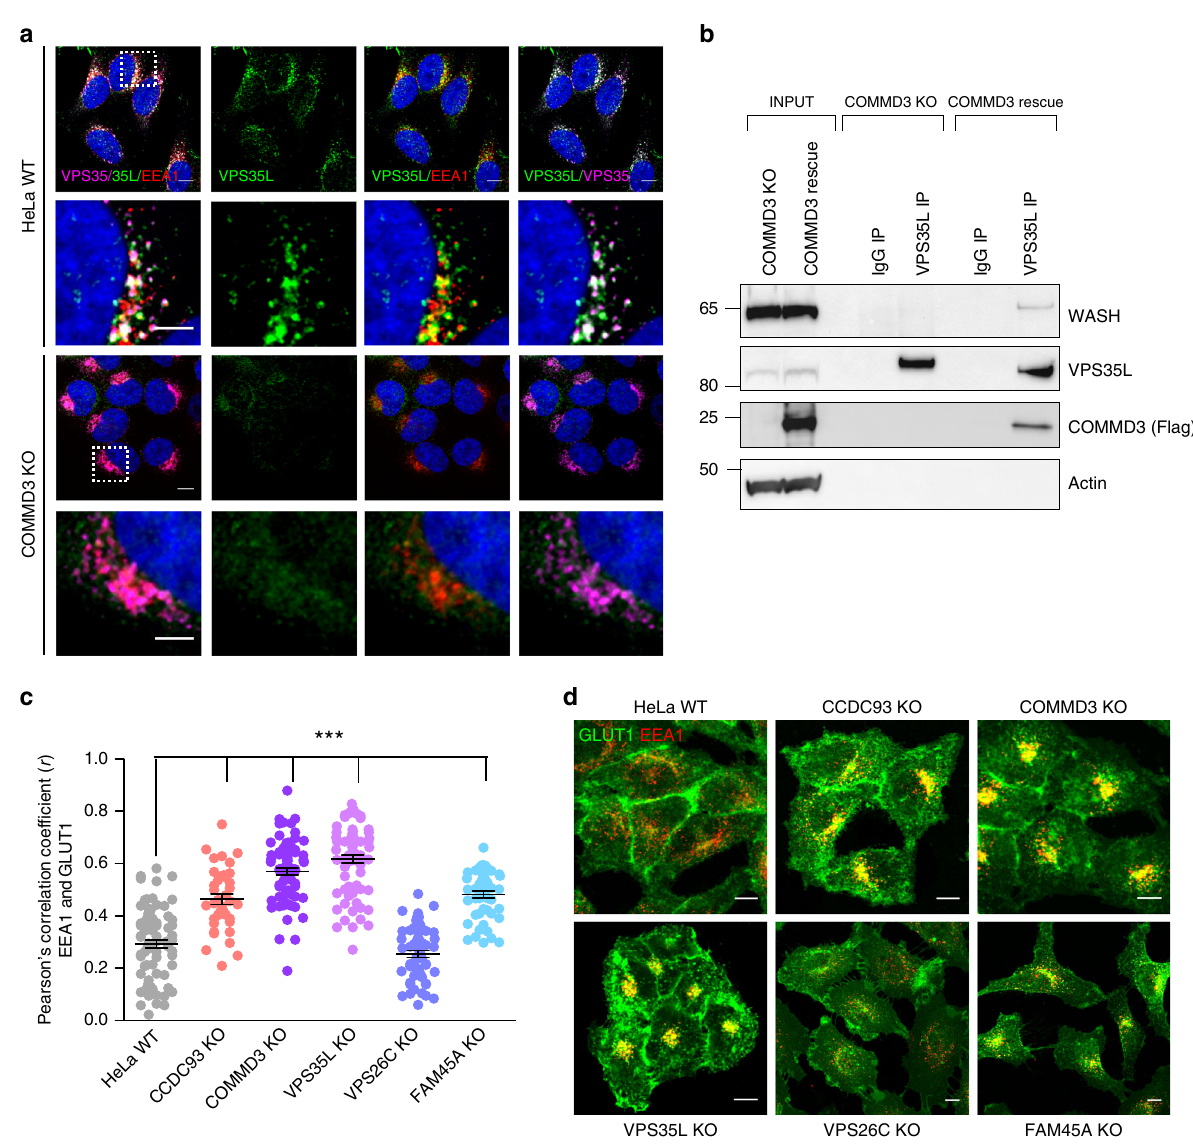
Fig. 2 CCC links retriever to endosomes but its loss affects retriever-independent cargoes. a Confocal images from VPS35L, EEA1, and VPS35 immuno fl uorescence staining depicting the subcellular localization of the retriever subunit VPS35L in the indicated cell lines. Representative images of two independent experiments are shown. Scale bars, 10 μ m, for zoomed images 5 μ m. b Immunoprecipitation of the retriever subunit VPS35L was followed by immunoblotting for WASH. Lysates from COMMD3 KO cells and an isogenic rescue line were used (representative of two independent iterations). c Pearson correlation coef fi cients for GLUT1 and EEA1. Results for individual cells are plotted, along with the mean and s.e.m. for each group ( n = 76 cells for WT, 76 for COMMD3 KO, 38 for CCDC93 KO, 72 for VPS35L KO, 59 for VPS26C KO, and 50 for FAM45A KO); *** P < 0.0001 (one-way ANOVA and Dunnett ’ s test to control). d Confocal microscopy imaging of EEA1 and GLUT1 immuno fl uorescence staining quanti fi ed in c . Representative images from three independent experiments are shown. Scale bars, 10 μ